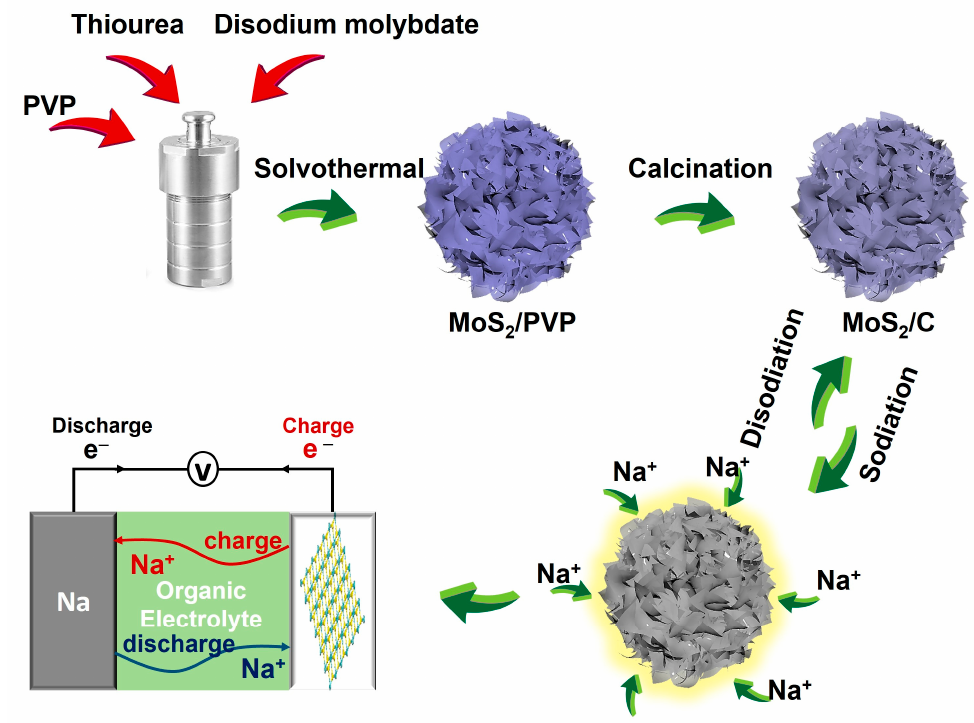
Scheme 1. Schematic illustration of the fabrication of hollow MoS 2 /C nanoflowers from diatomite as SIB